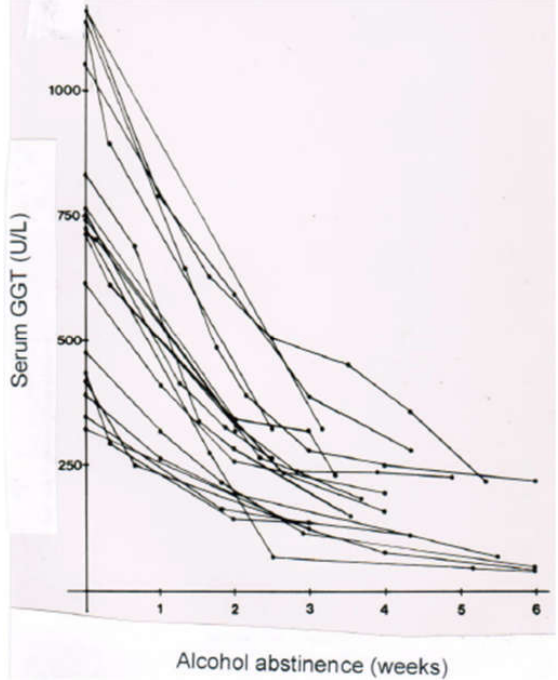
Figure 16. Decline of serum gamma‐glutamyltransferase (GGT) activities due to alcohol abstinence. Alcohol abstinence leads to a reduction of serum activities of GGT in patients with alcoholic liver disease of all stages including alcoholic fatty liver, alcoholic steatohepatitis, alcoholic hepatitis, and alcoholic cirrhosis. This approach is extremely valuable in any clinical setting for checking whether a patient has followed the professional advice to stop alcohol use. The original figure was published in a previous report [301] and is reproduced with the permission of the Publisher Springer (Berlin, Germany).